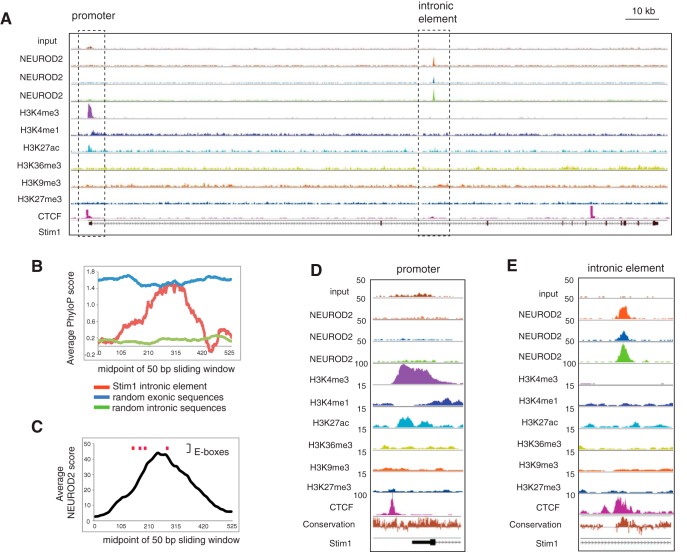
NEUROD2 binds to a conserved intronic element within the Stim1 gene. A, Input DNA or ChIP-Seq tracks acquired from three separate NEUROD2 antibodies or various histone modifications along the Stim1 gene are plotted. B, The midpoint of a 50 bp sliding window across a 550 bp stretch is plotted as a function of its average evolutionary conservation score (PhyloP score). Blue and green traces represent the average of 20 randomly selected exonic or intronic sequences within the Stim1 gene, respectively. The red trace represents the NEUROD2 binding sequence within intron 2. C, The midpoint of a 50 bp sliding window encompassing the NEUROD2 binding sequence within intron 2 is plotted as a function of NEUROD2 ChIP-Seq score (MACS score from NEUROD2 ChIP-Seq with antibody 2). Red lines denote the locations of E-boxes. D, E, A closer view of Stim1 promoter and intronic element are presented. Enrichment of promoter-associated histone modifications H3K4me3 and H3K27ac are observed proximal to Stim1 TSS. While no NEUROD2 binding is observed at the Stim1 promoter, all three antibodies reveal strong enrichment at a specific sequence within intron 2.